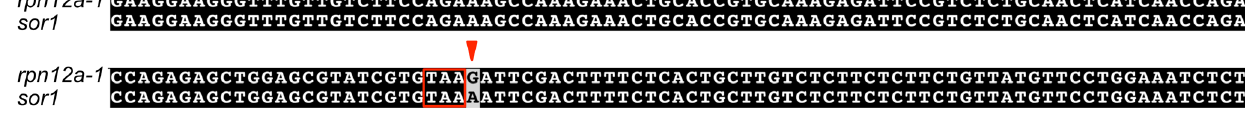
Figure 5. Sequence alignment of the RPN12a gene (At1g64520) in rpn12a‑1 and sor1 . Genomic DNA fragment was amplified using F1 and R2 primers (presented in Figure 3), sequenced and the sequence was aligned using Vector NTI suite. Alignment of the region starting with base pair 1615 and ending with base pare 1804 of the annotated RPN12a gene is presented using BoxShade 3.2. The red arrowhead points to the sor1 mutation and the RPN12a STOP codon is boxed in